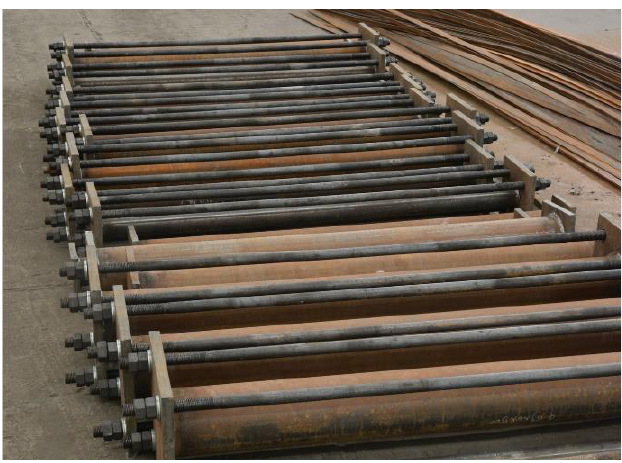
Figure 3. Specimens fabricated in the factory.